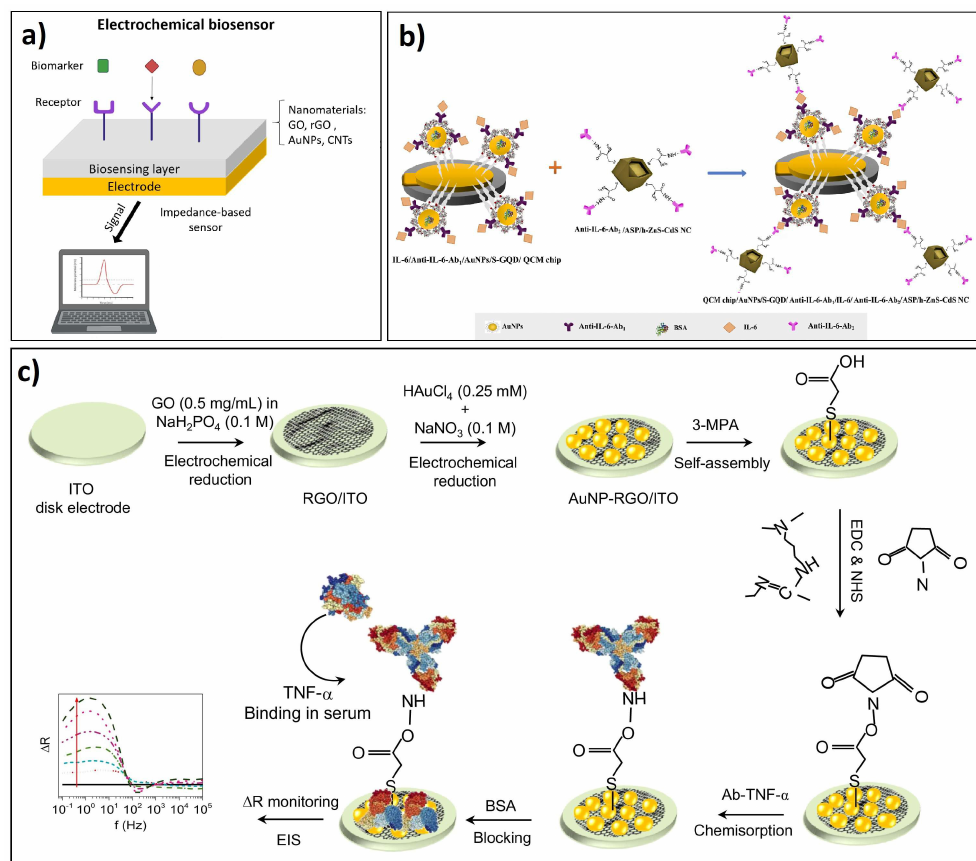
Figure 2. Electrochemical biosensors. ( a ) Schematic illustration of the general design of an impedance-based biosensor. ( b ) Surface design of a sandwich-type electrode biosensor based on functionalized sulfur-doped GQD for IL-6 detection. ( c ) Design and manufacture of ITO disk electrode for biosensing of TNF- α . Source : ( b , c ) reproduced from [127,128] with permission of